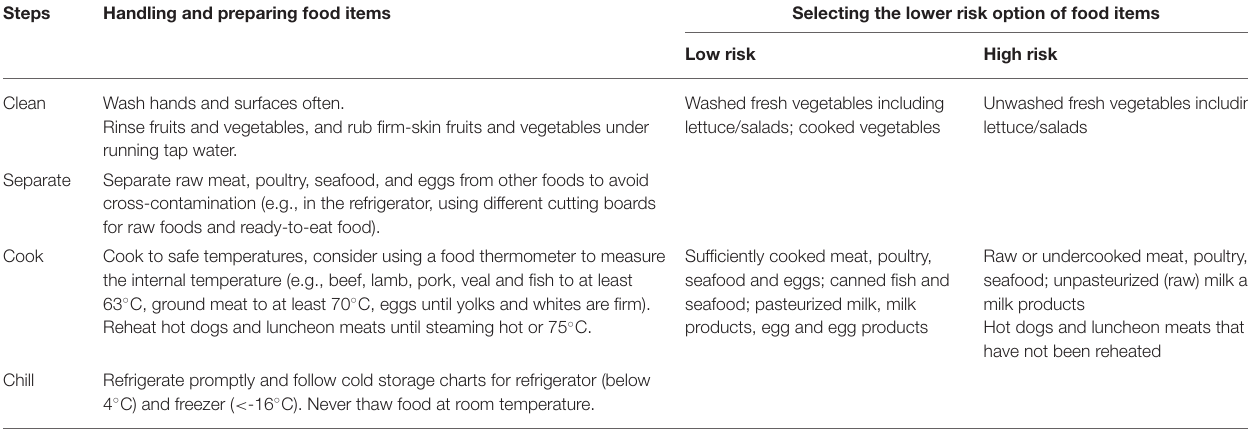
TABLE 1 | Handling of food items during allogeneic hematopoietic cell transplantation. Steps Handling and preparing food